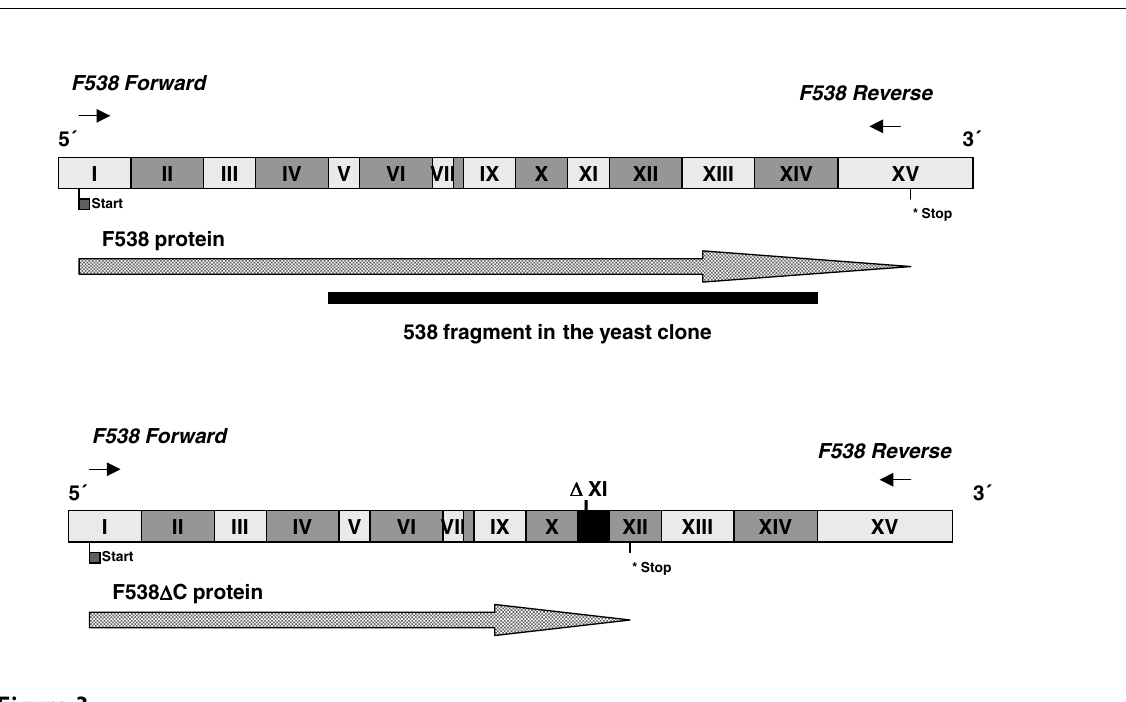
Figure 3 Exon structure and cloning strategy for the full length F538 and the C terminal truncated splice